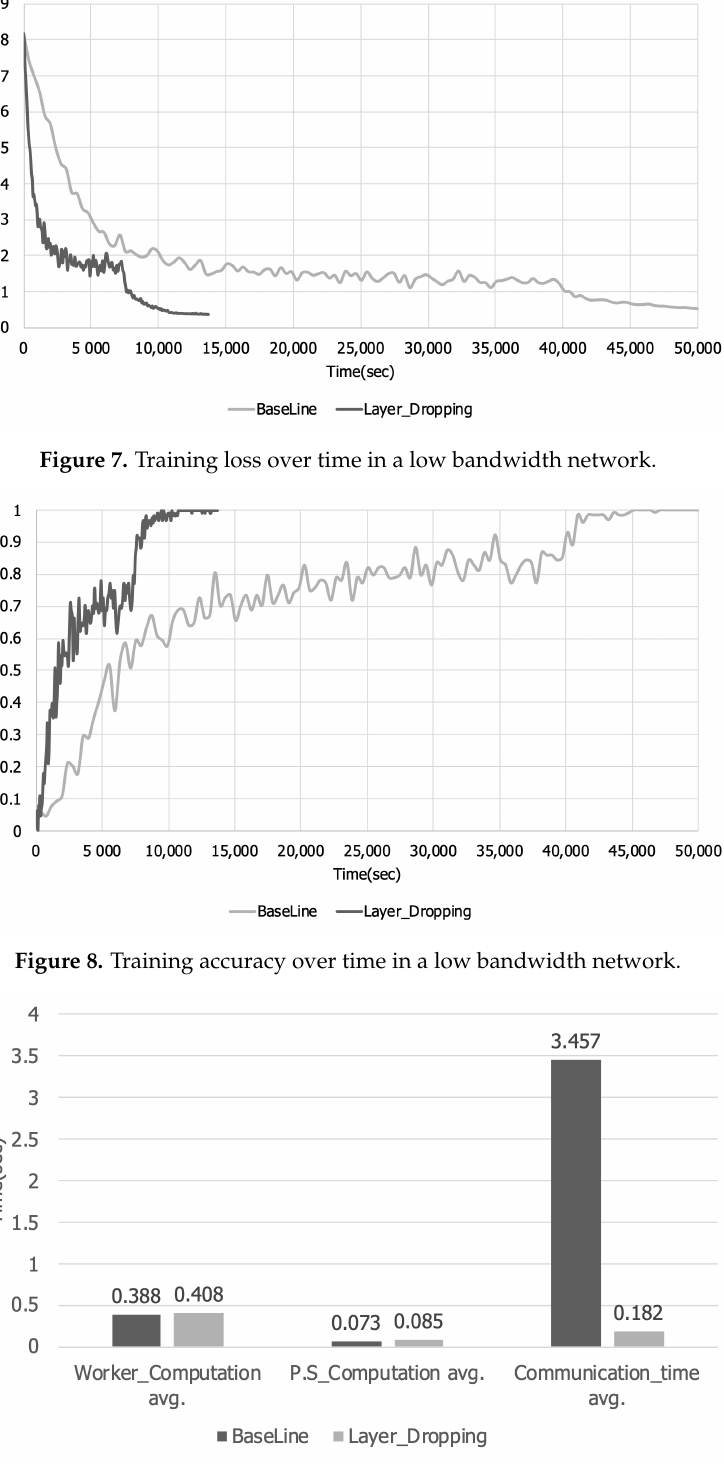
Figure 9. Communication time and computation time in a low bandwidth